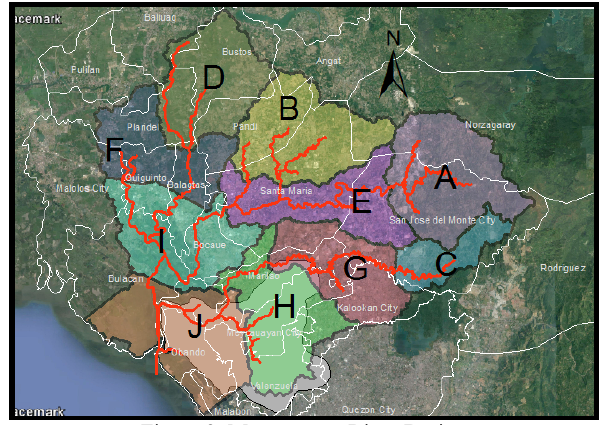
Figure 2. Meycauayan River